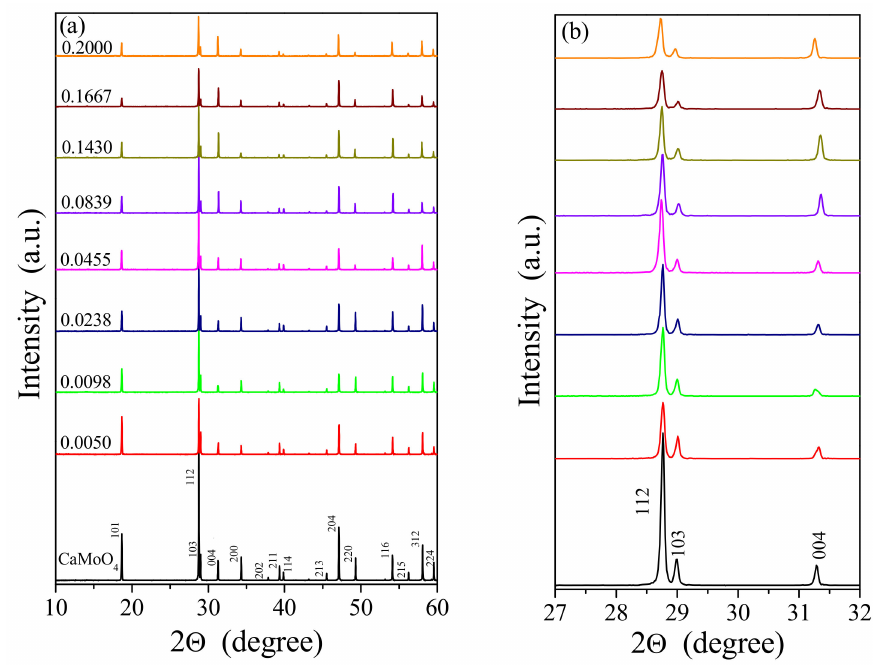
Figure 1. ( a ) Powder XRD patterns of CaMoO 4 and CCGMWO ceramics within the 2 Θ range of 10–60 ◦ ; ( b ) 112/103/004 diffraction lines in the range of 2 Θ from 27 ◦ to 32 ◦